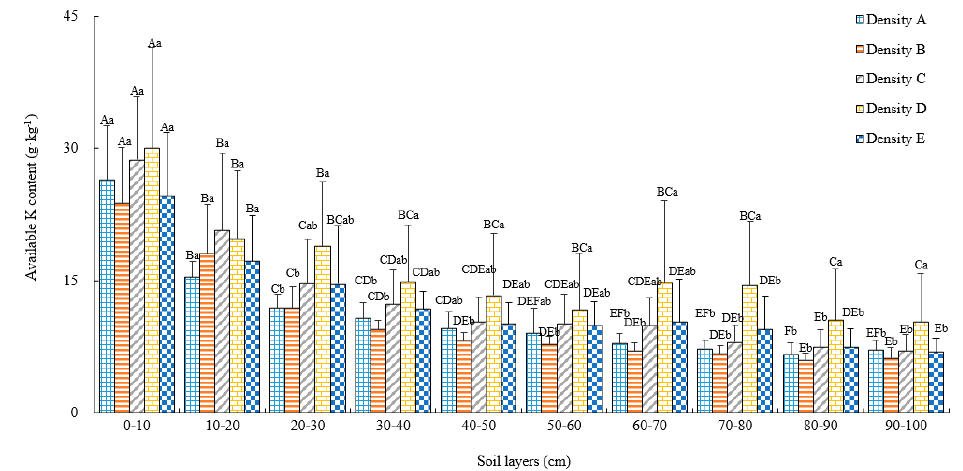
Figure 8. Soil available K in different layers under different stand densities (mg·kg − 1 ). Note: different lowercase letters indicate significant differences among different densities at the 0.05 level, and different capital letters of the same density indicate significant differences among different soil layers at the 0.05 level.